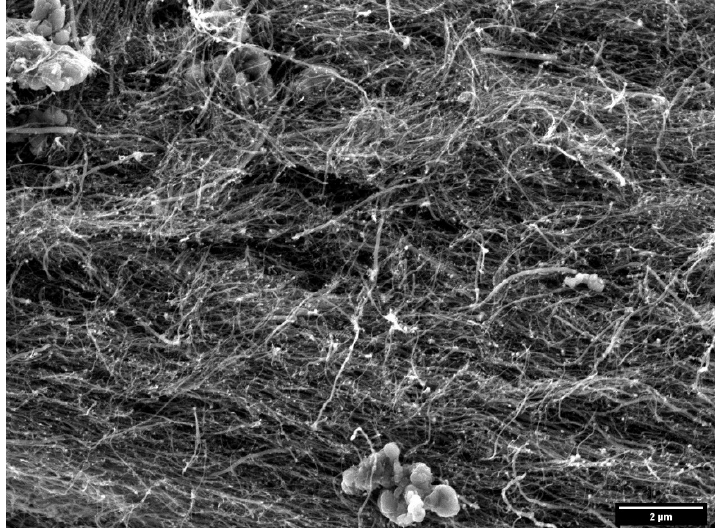
Figure 3. Scanning electron microscopy of MWCNTs produced using polystyrene dissolved in toluene as the carbon source and ferrocene as a source of iron catalyst. Residual catalyst and amorphous carbon impurities are present here, although the vast majority of the product remains CNTs.